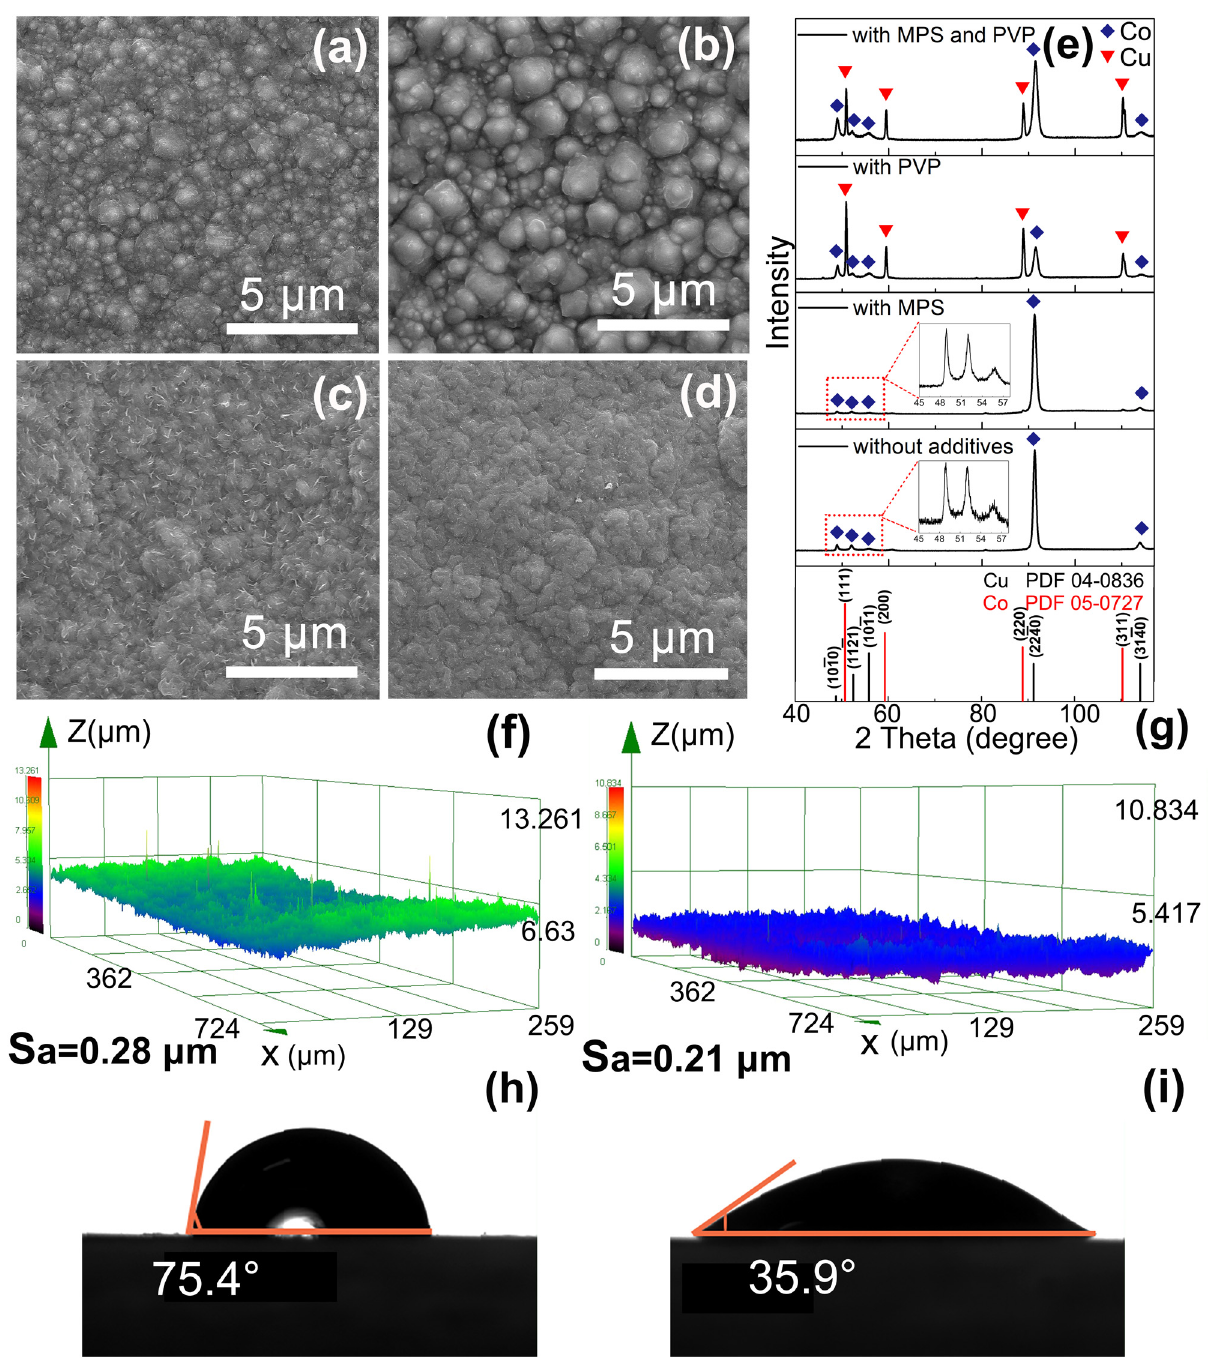
Figure 7: SEM images of the electrodeposited cobalt in solution without additives ( a ) and with only 7 mg/L MPS ( b ) , only 300 mg/L PVP ( c ) , 7 mg/L MPS, and 300 mg/L PVP ( d ) . The XRD pattern of the electrodeposited cobalt ( e ) . 3D roughness tests of the electroplated cobalt surface and the contact angle images of the plating solution on the electrodeposited cobalt without additives ( f and h ) and with 7 mg/L MPS and 300 mg/L PVP ( g and i )